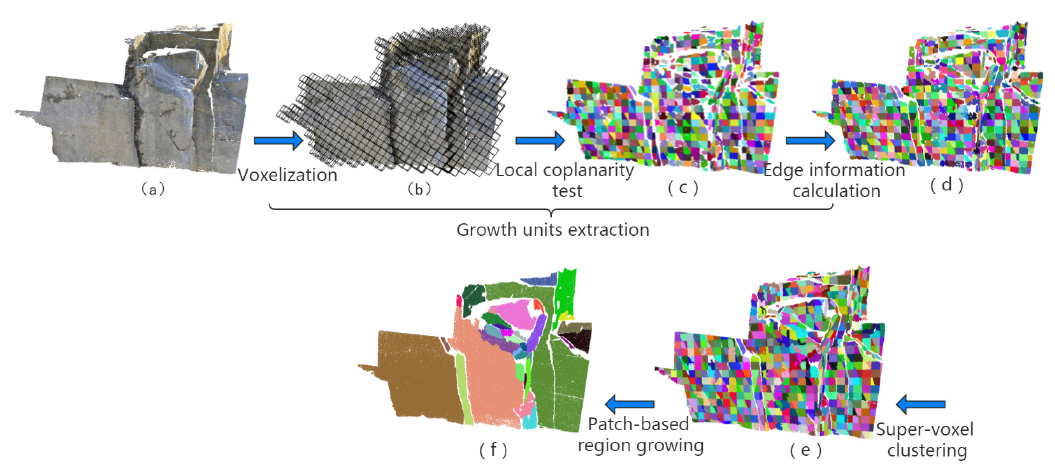
Figure 1. Algorithm flowchart. ( a ) Input point cloud. ( b ) Voxel segmentation. ( c ) Major segment extraction. ( d ) Edge optimization. ( e ) Detail preservation. ( f ) Final